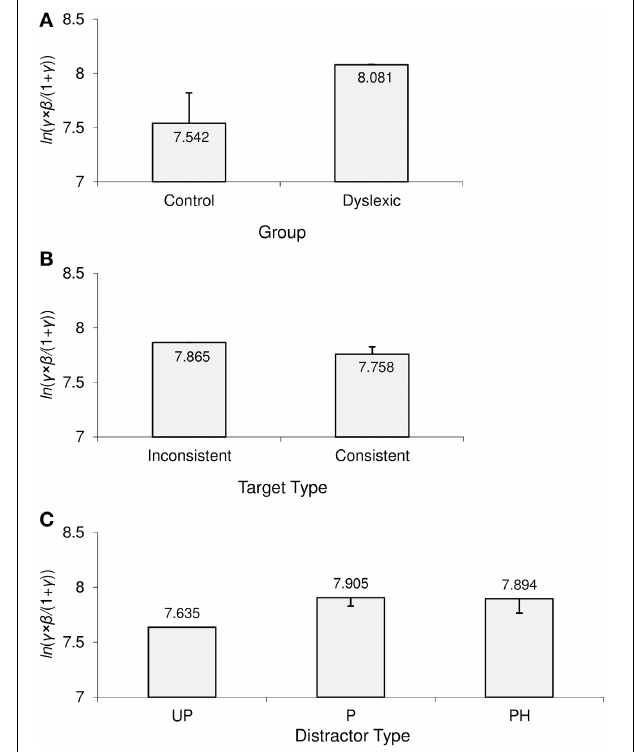
FIGURE 6 | Significant effects in initial uncertainty time [ln( δ )]. (A) Main effect of group; (B) main effect of target type; (C) main effect of distractor type. Error bars represent Sidak-adjusted 95% confidence half-widths for (A) the group contrast, (B) the target type contrast, and (C) contrasts with the UP distractor condition. Significant differences must exceed those half-widths. UP, unpronounceable; P, pronounceable; PH, pseudohomophone.